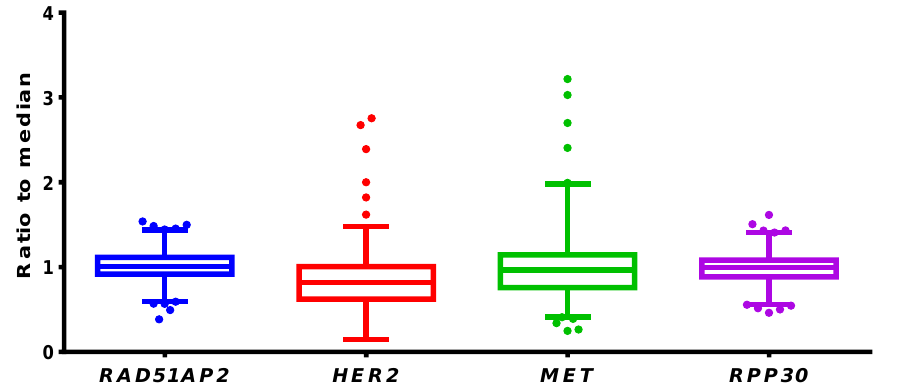
Figure 9. Results of NSCLC FFPE sample analyses by ddPCR. Tukey box-and-whiskers plot, X-axis represents genes, Y-axis represents the ratio of gene concentration to median concentration for both reference loci.